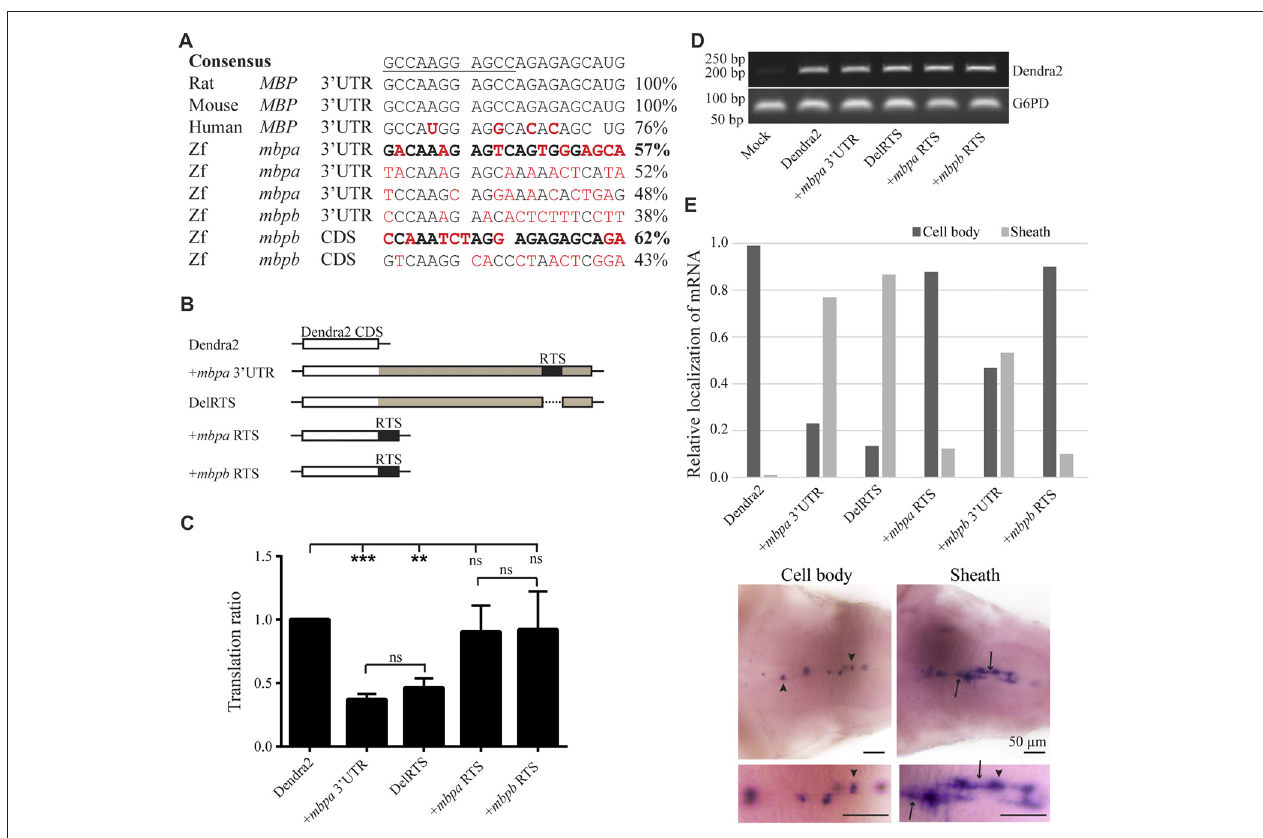
FIGURE 7 | The proposed RNA trafficking sequence (RTS) sequences from mbpa and mbpb do not affect protein translation or mRNA transport. (A) The RTS consensus sequence (the hnRNP A2-binding site, A2RE11, is underlined) and the specific sequences of the rat, mouse and human RTS are shown together with proposed RTS sequences from zebrafish mbpa and mbpb mRNA. Nucleotides differing from the consensus are marked in red. The sequences from mbpa and mbpb with the highest similarity to the consensus are marked in bold. (B) The constructs tested in the translation assay are illustrated. The mbpa and mbpb RTS corresponds to the sequences marked in bold in (A) . (C) The constructs shown in (B) were co-transfected with a DsRed-expressing vector into Oli-Neu cells and the translation ratio calculated as described in the “Materials and Methods” section. Data represent the means of four individual experiments ± SD. ns = not significant, ∗∗ p < 0.01, ∗∗∗ p < 0.001. (D) RNA was extracted from a fixed number of transfected cells and RT-PCR was performed with primers specific for Dendra2 or G6PD (control). (E) The localization of mRNA in larvae with mosaic expression of the indicated constructs was defined as “Cell body” or “Sheath”. Examples of both groups are shown below the chart. Cell bodies are marked with arrowheads, while sheaths are marked with arrows. Bottom micrographs are enlarged views of top images. The relative fraction of cells with each type of mRNA distribution is plotted. For + mbpb RTS, 10 cells were analyzed. For all other constructs, 77–173 cells were